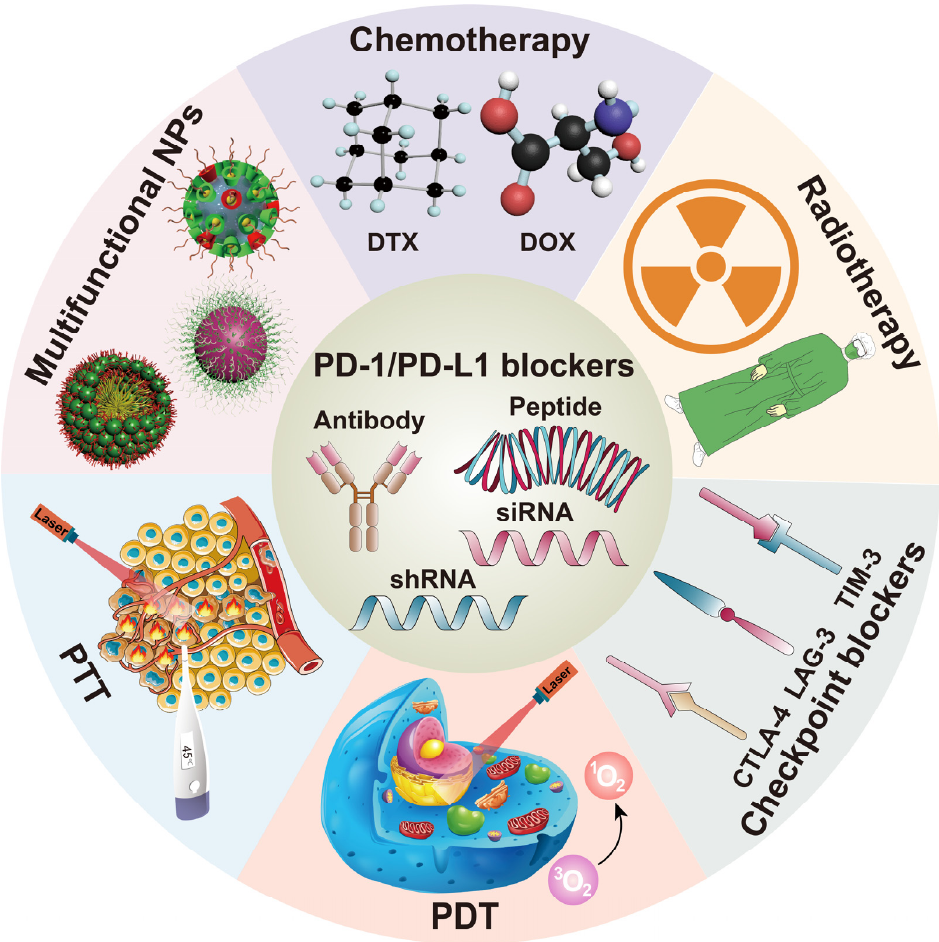
Figure 2. A scheme to illustrate the rationale strategies combining PD-1/PD-L1 blockers with other therapies using nanoplatforms. PDT, photodynamic therapy; PTT, photothermal therapy; NPs, na- noparticles.